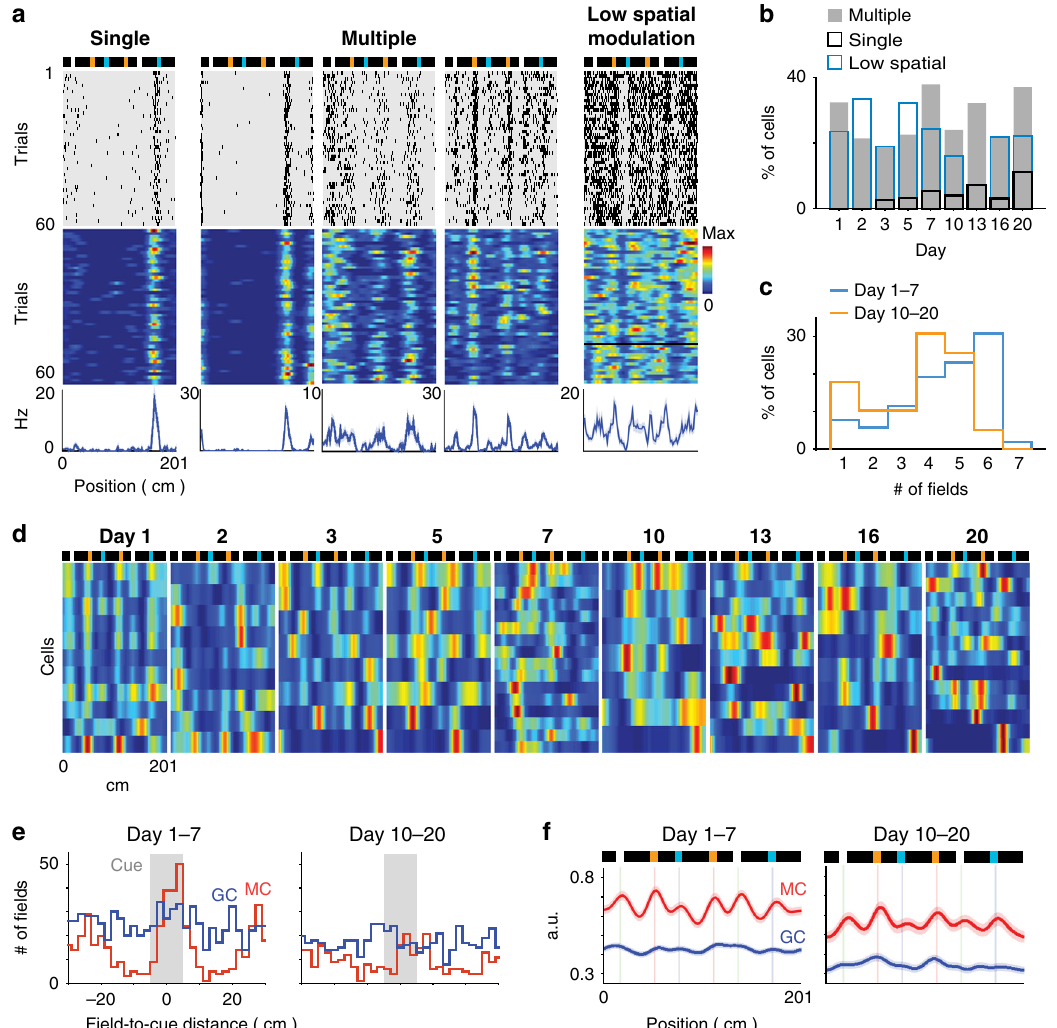
Fig. 6 MC overrepresentation of landmarks. a Individual cell examples for various types of MC representations. From left to right, a single- fi eld cell, three multiple- fi eld cells, and a cell with low spatial modulation. Top, scheme of the belt; middle, spike raster plot and color-coded fi ring rate map; bottom, the mean fi ring rate. b Proportion of MCs with single fi elds (black), multiple fi elds (gray) and low spatial modulation (blue), across days. c Distribution of the number of fi elds per cell for days 1 – 7 and days 10 – 20 among MCs exhibiting place fi elds. The number of place fi elds per cell was reduced across days ( t 89 = 2.8, p = 7e − 3 , two-tailed unpaired t test). d Color-coded rate maps for MCs exhibiting fi ring fi elds across days. The rows of the matrices correspond to individual MCs and are sorted according to fi ring fi eld positions. The color scale is the same as that used in ( a ). e Distribution of fi eld-to-landmark distances for GC (blue) and MC (red) place fi elds for days 1 – 7 (left) and days 10 – 20 (right). f Average of GC (blue) and MC (red) rate maps (line, the mean; shadow, s.e.m.) for days 1 – 7 (left, n = 1159 GCs and 181 MCs) and days 10 – 20 (right, n = 540 GCs and 112 MCs). Note the increase in MC (but not GC) activity in landmark